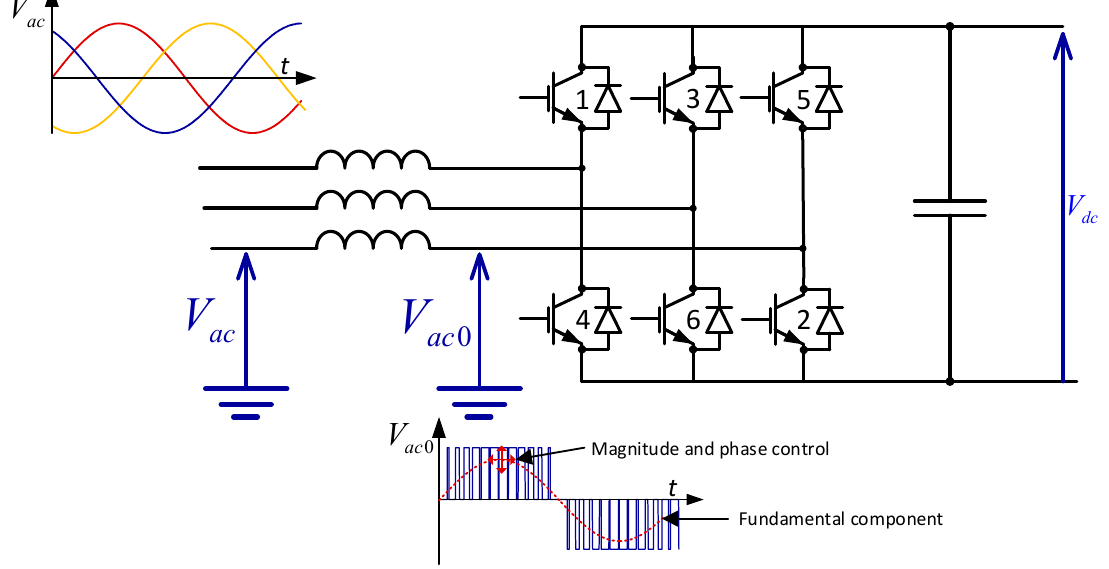
Figure 6. A self-commutated Voltage Source Converter (VSC).